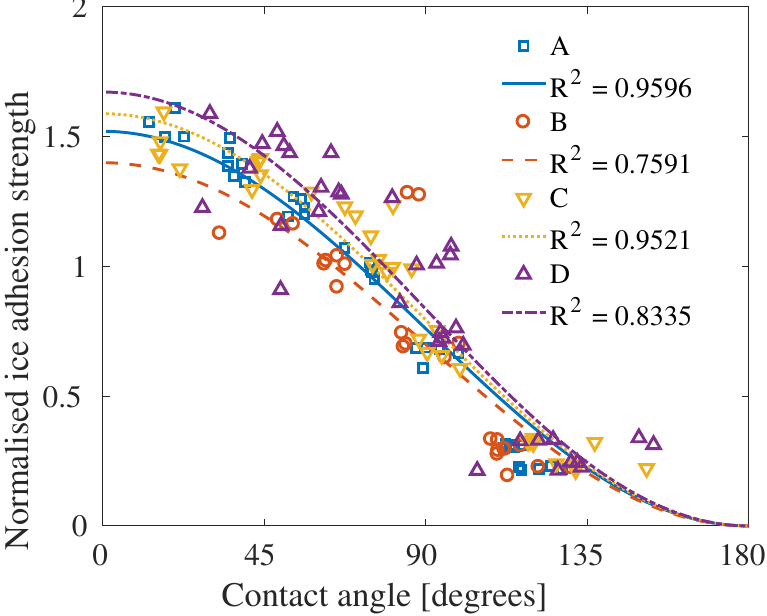
Figure 10. Overview of the correlation with Equation (7) for the four systems investigated in this study. The ice adhesion strength has been normalised with respect to the mean value from the interaction energy ε 0 . Data from the four individual systems is given in Figure